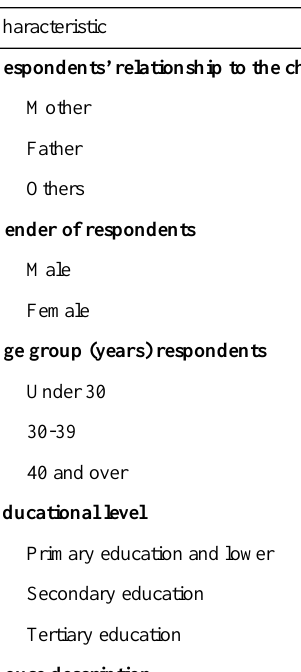
Table 1. Participants characteristics